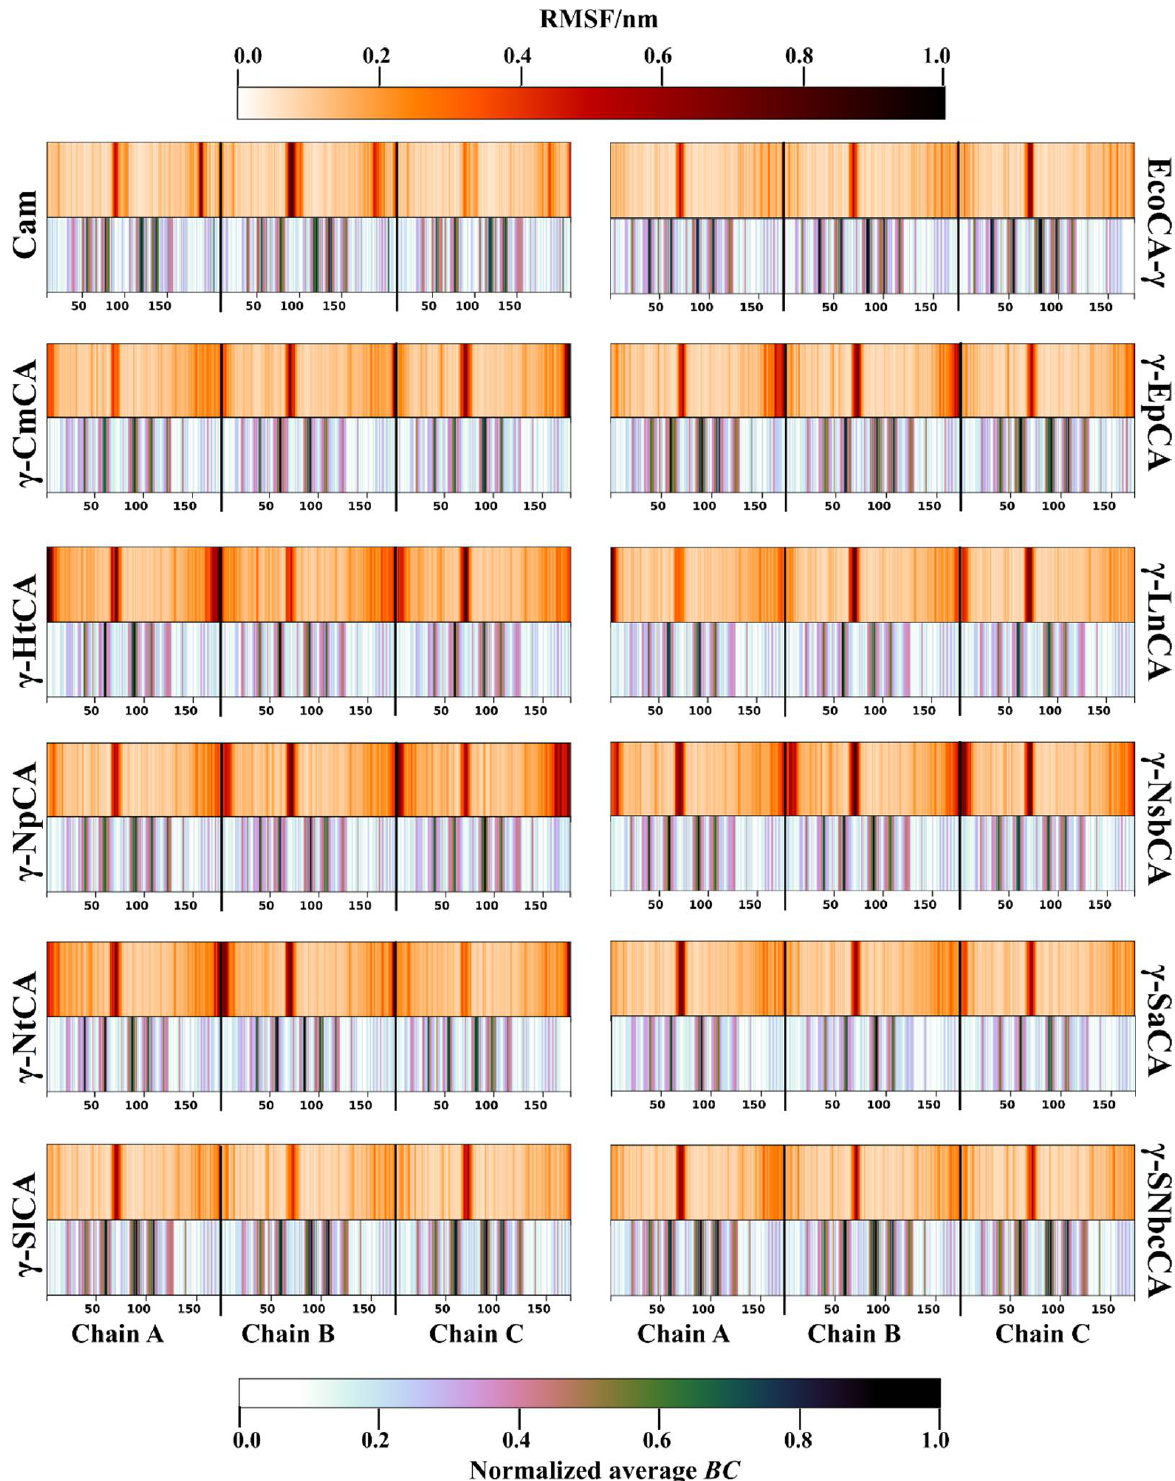
Figure 4. Root mean square fluctuation (RMSF) ( top ) and normalized average betweenness centrality ( BC ) ( bottom ) heatmaps of the γ-CAs simulated.